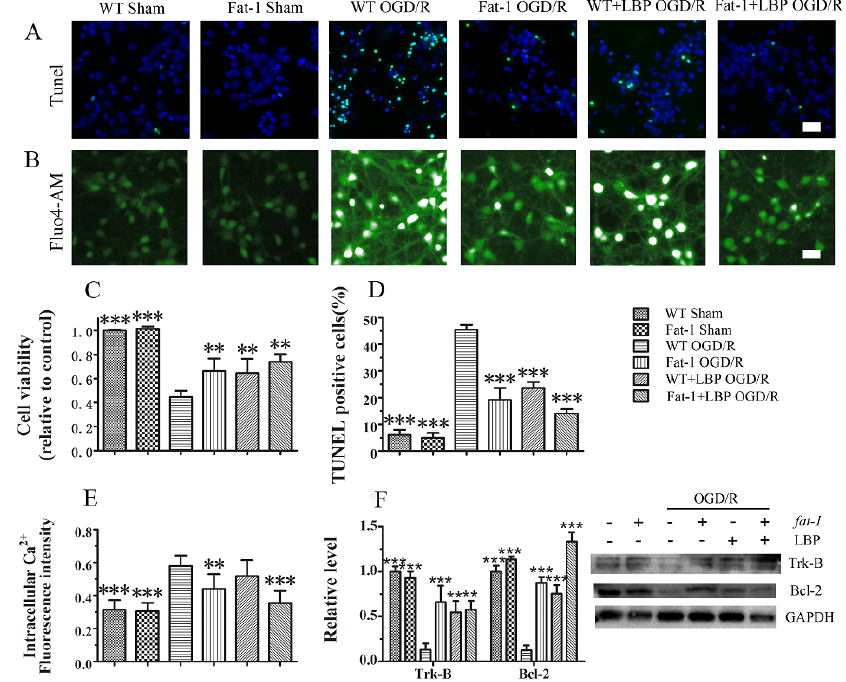
Figure 4. LBP and endogenous ω -3 PUFAs significantly prevent OGD/R-induced neuronal apoptosis respectively via intracellular Ca 2+ handling or neurotrophic pathway activation: ( A ) TUNEL staining; ( B ) fluorescent micrographs showing intracellular Ca 2+ levels as stained by the Fluo4-AM dye; ( C ) statistic of cell viability; ( D ) statistic of TUNEL positive cells; ( E ) results of relative fluorescence intensity analysis of intracellular Ca 2+ ; and ( F ) expression levels of Trk-B and Bcl-2 measured by Western blot. Data are presented as mean ± SEM, ** p < 0.01, *** p < 0.001 indicate significant difference compared with the WT OGD group; p < 0.05, p < 0.01 indicates significant difference compared